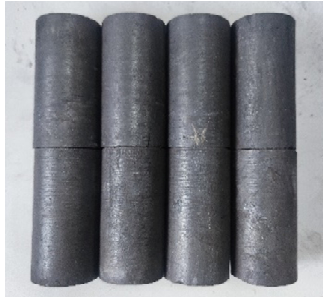
Figure 1. Standard test samples.